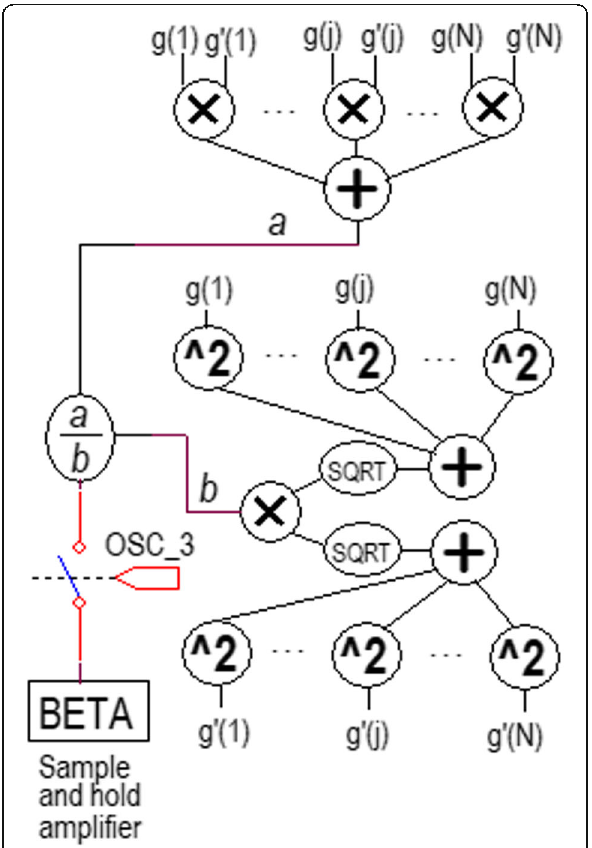
Fig. 8 A circuits for updating parameter β